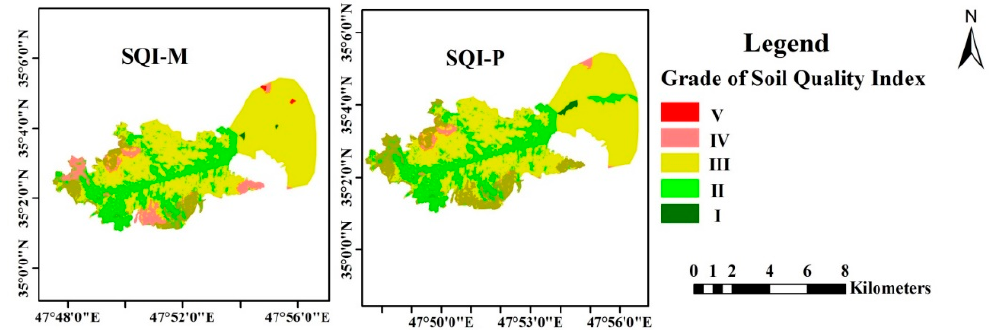
Figure 3. Soil quality grade distribution SQIs using two weighting methods (SQIw-M and SQIw-F). The root mean square error (RMSE), and R 2 values achieved 0.04 and 0.71 (SQIw-M), and 0.05 and 0.70 (SQIw-F), respectively. Table 6. Classification and percentage of soil quality grades for two soil quality indices (SQIw-M and SQIw-F) in two soil orders.